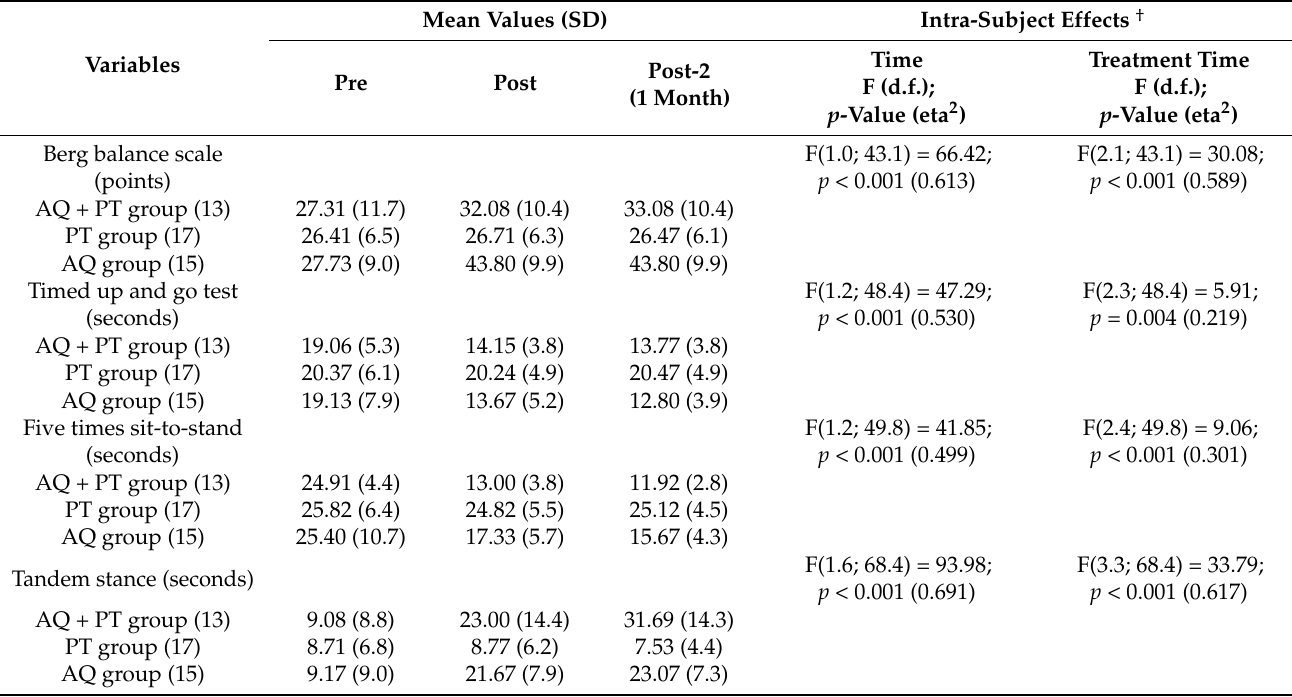
Table 2. Mean values (SD) of the clinical evaluations and intra-subject GLM